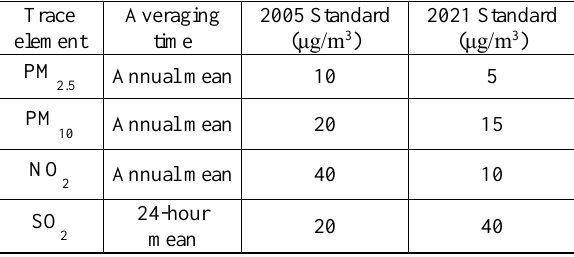
Table 1: Air quality standards comparison of year 2005 and 2021 set by World Health Organization